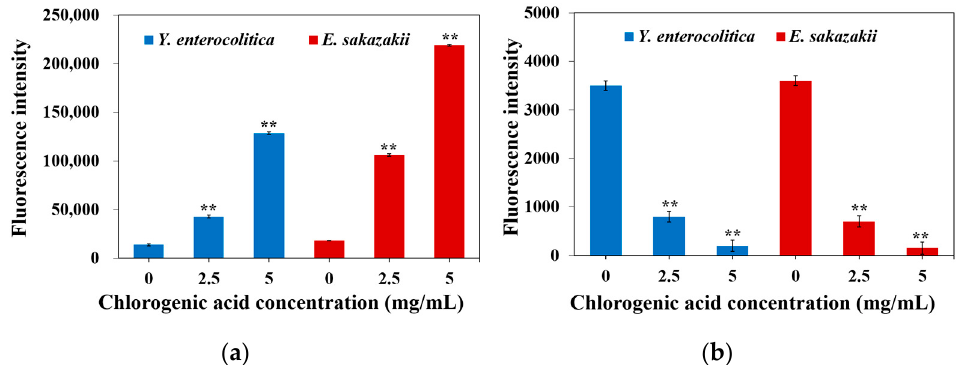
Figure 3. Effect of CA on the ( a ) membrane potential level and ( b ) intracellular ATP level of Y. enterocolitica and E. sakazakii . Error bars represent the standard deviation ( n = 3). ** p ≤ 0.01 represent significant differences between the treatment group and control group.